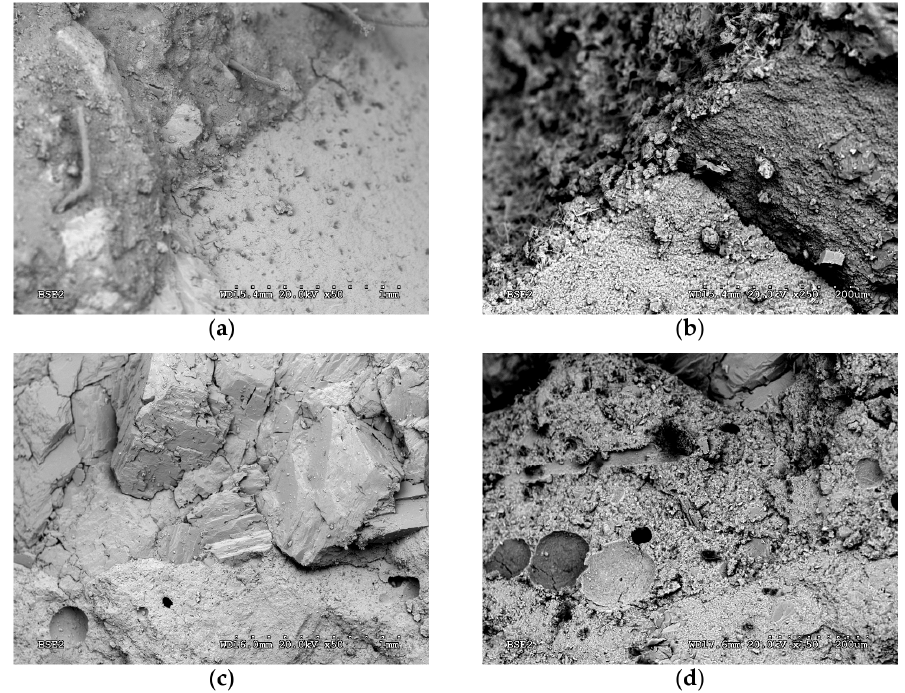
Figure 7. Scanning electron microscope photographs: A0 batch at room temperature ( a ) and at 550 °C ( b ); A100 batch at room temperature ( c ) and at 550 °C ( d ).